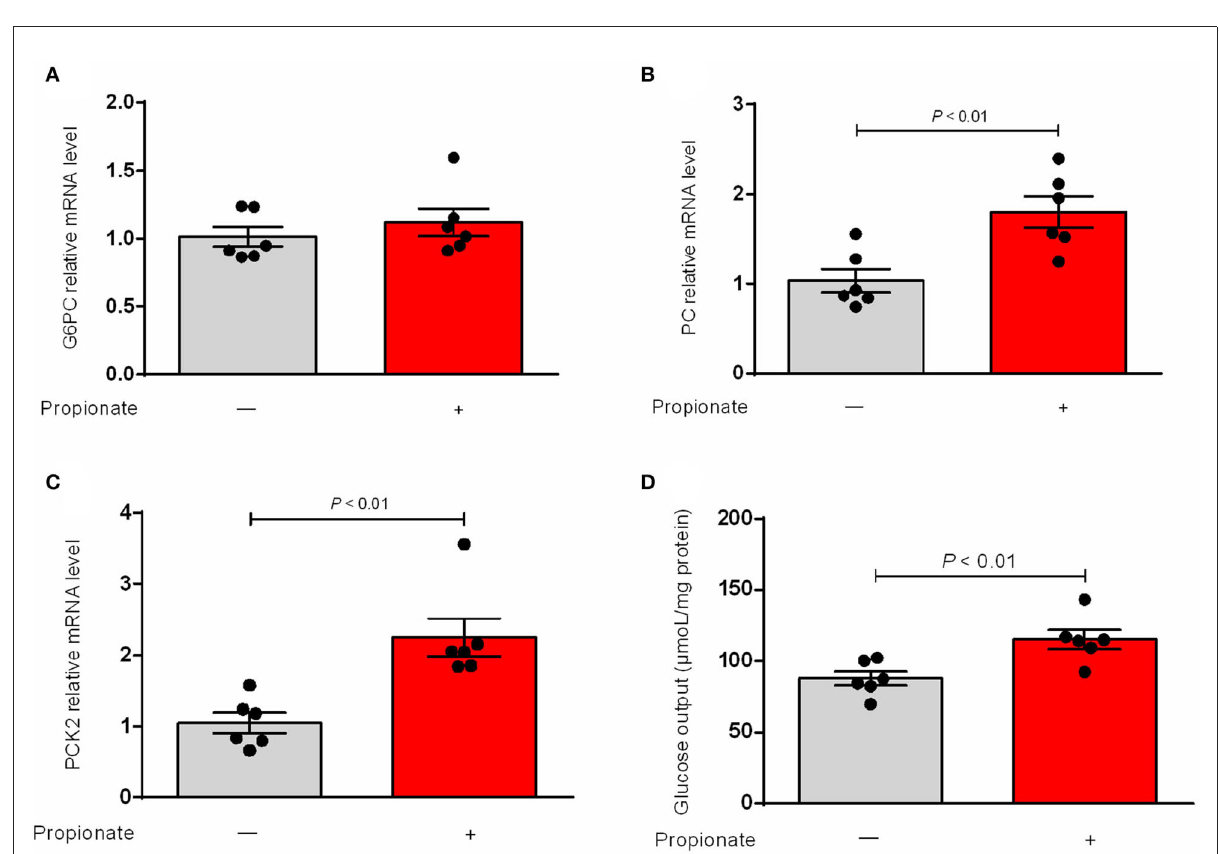
FIGURE1 Effect of propionate on mRNA relative level of genes involved in gluconeogenic and glucose output in bovine hepatocytes. qRT PCR analysis of G6PC (A) , PC (B) , and PCK2 (C) expression levels ( n = 6). GAPDH was used as an internal reference gene. (D) Propionate on the content of glucose output in bovine hepatocytes ( n = 6). The relative expression of target genes was normalized to that of GAPDH. P < 0.05 were considered significant and < 0.01 were highly